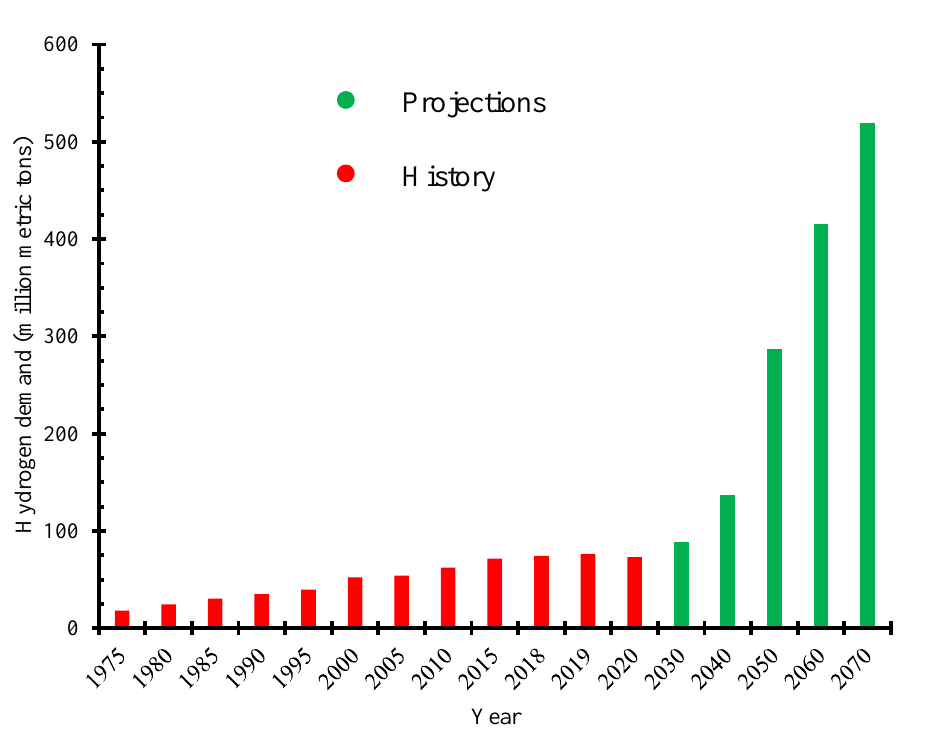
Figure 6. Global demand for hydrogen (Million Metric Tons) from 1975–2020 and 2030–2070 projec- tions. Compiled and adapted by the authors from [69,71].